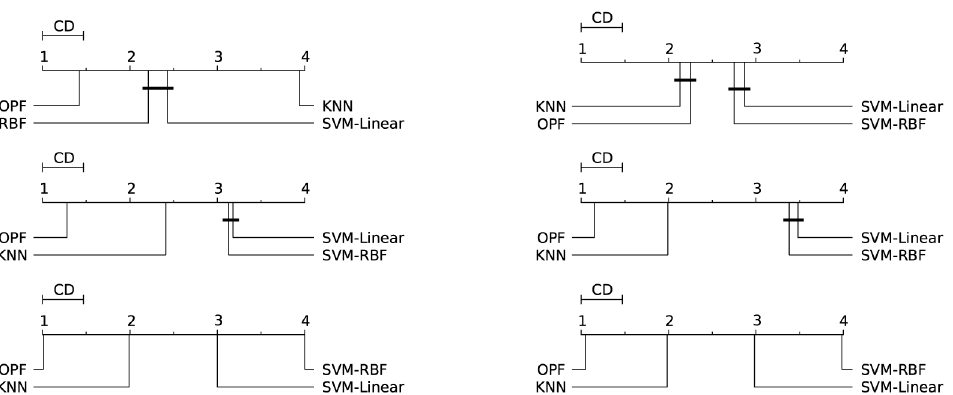
Fig 6. IJCNN 2001. Comparison of all classifiers against each other with the Nemenyi test and learning time constraint equals to 1, 5, 20, 60, 300, and 1200 seconds. Groups of classifiers that are not significantly different (at p = 0.05) are connected.